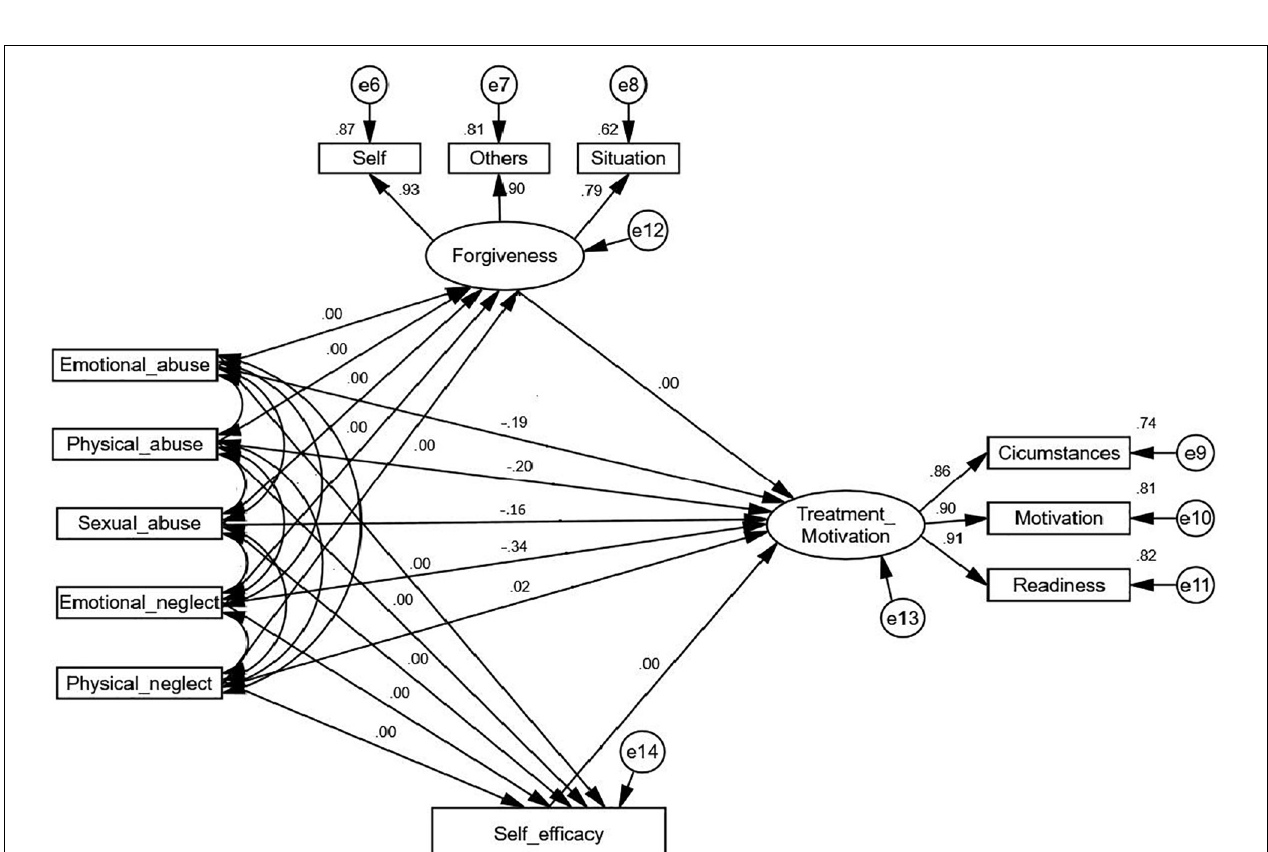
FIGURE 4 | The direct model of various forms of maltreatment. All indirect paths constrained to 0.